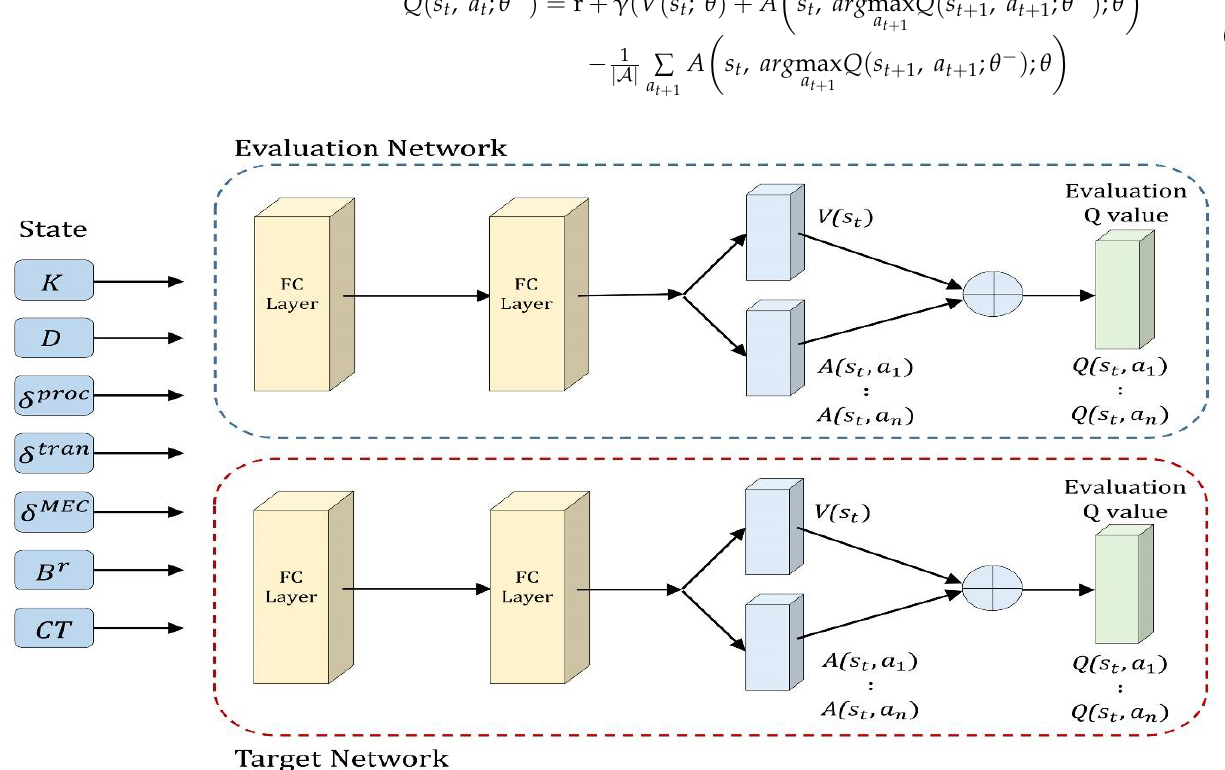
Figure 5. Network architecture of D3QN.